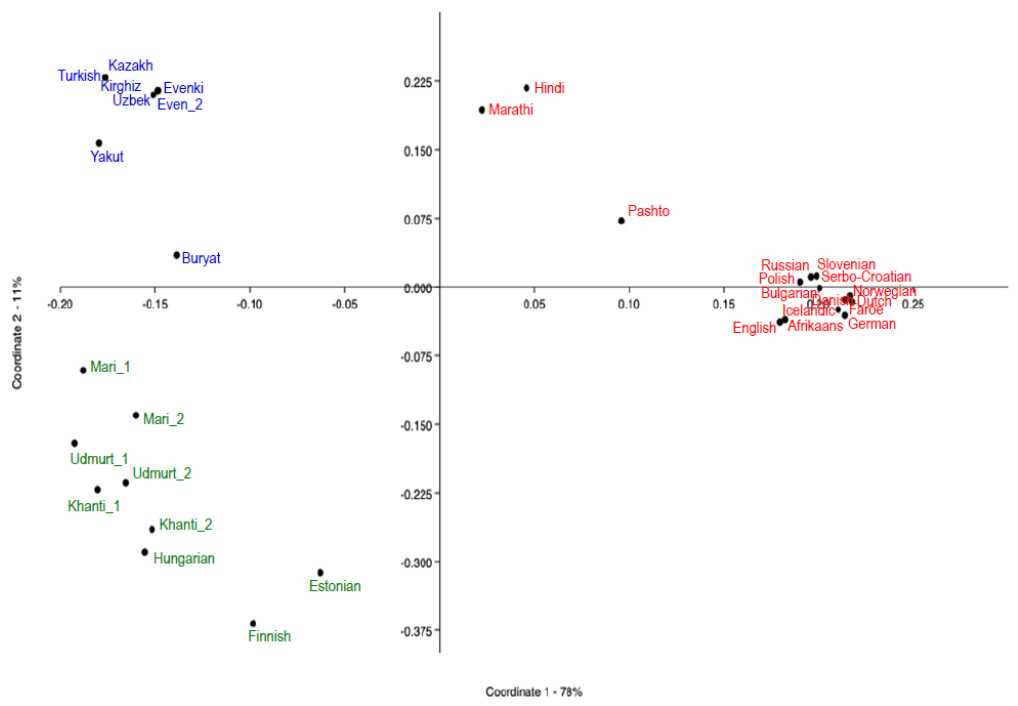
Figure 1. Principal Coordinate Analysis (PCoA) from the syntactic distances in 34 Eurasian populations. Language groups coded as follow: Finno-Ugric ( green ), Altaic ( blue ), Indo-European ( red